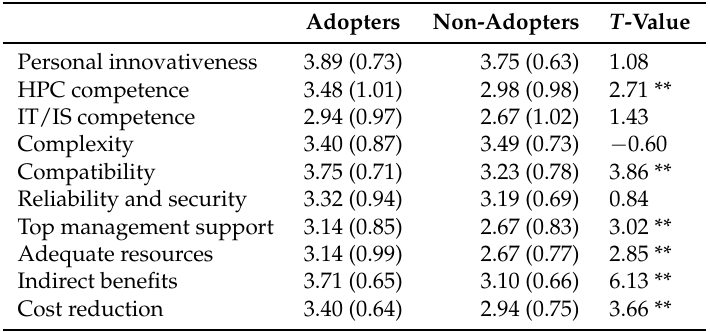
Table 4. T -test results of perceptions between adopters and non-adopters.